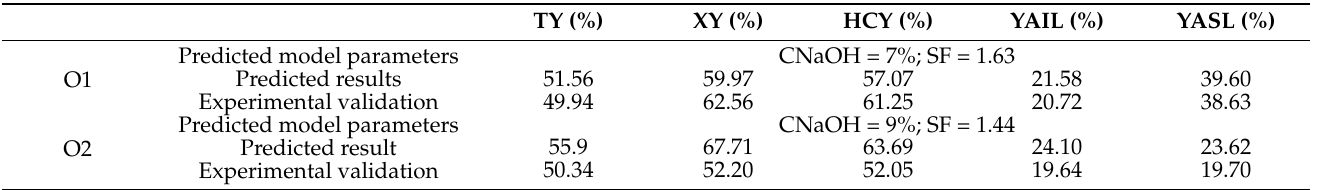
The optimized conditions of wheat straw hemicellulose extraction and obtained experimental